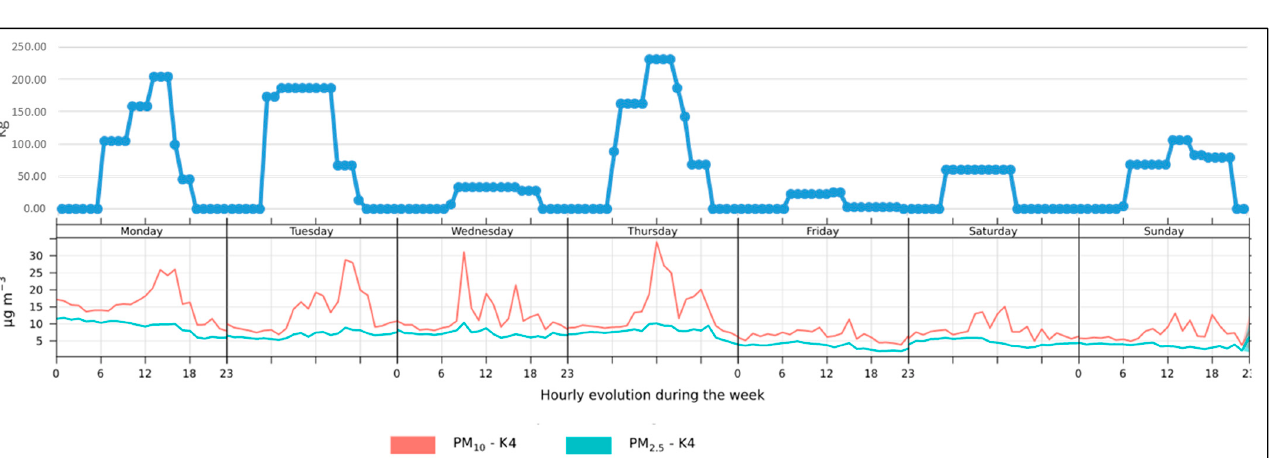
Figure 9. Bivariate polar plot of PM 2.5 ( a ) and PM 10 ( b ) concentrations at the K4 measuring location during experimental period from 20 August to 15 September 2022. Each plot’s center indicates a wind speed of zero, which rises radially outward. The color scale indicates the concentration of PM.